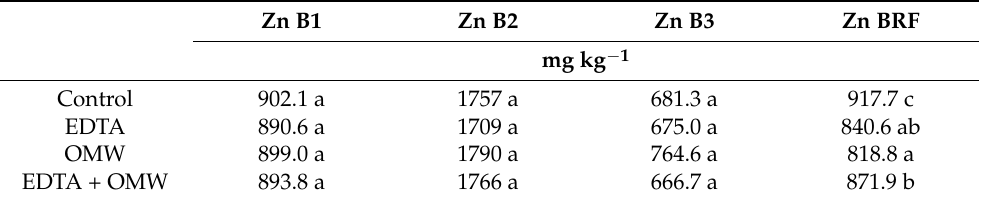
Table 4. Zn distribution between different soil fractions as determined by the BCR sequential extraction protocol, among different treatments. Comparisons performed by Tukey’s HSD test ( p ≤ 0.05) are demonstrated with lowercase letters and are valid within each soil fraction. The presence of a common letter implies no significant difference ( n = 3). Zn B1 Zn B2 Zn B3 Zn BRF mg kg − 1 902.1 a